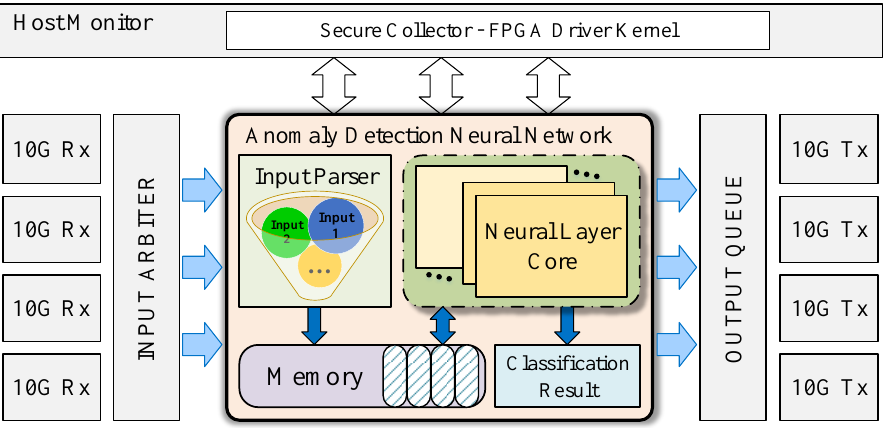
Figure 8. Logic view of the ANIDS Server implementation on the NetFPGA-sume